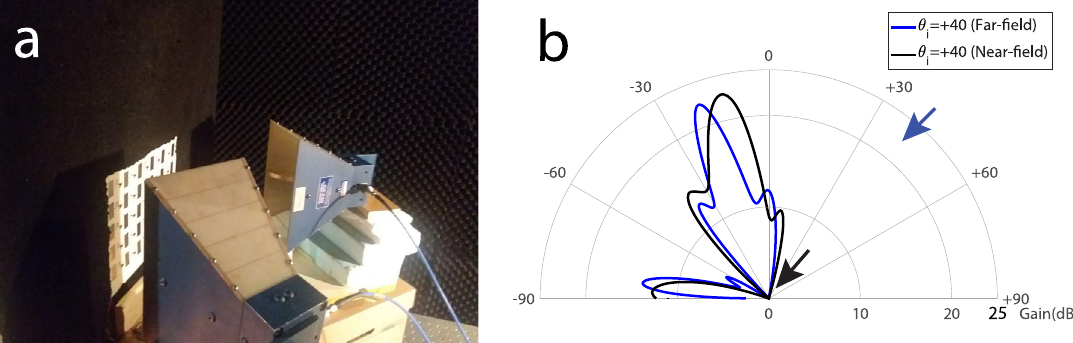
Fig. 10 Experimental results for near- fi eld ef fi ciency of the re fl ective metasurface at 5.81 GHz. a A photo of the near- fi eld experimental set-up. b Near- fi eld beam versus far- fi eld beam of the metasurface for wave incidence upon the angle of incidence θ